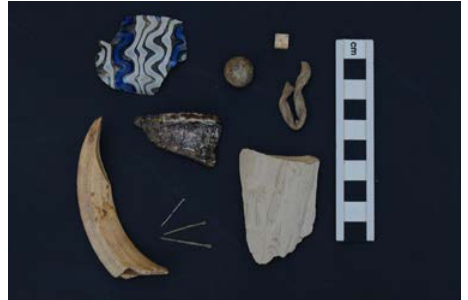
Fig. 9: Various finds from the site, from top left; Venetian glassware, a musket ball, an ivory die, lead came (window lead), a sherd of Sieberg ware, copper alloy pins, the rim of a lacquer drinking cup, and a boar tusk.